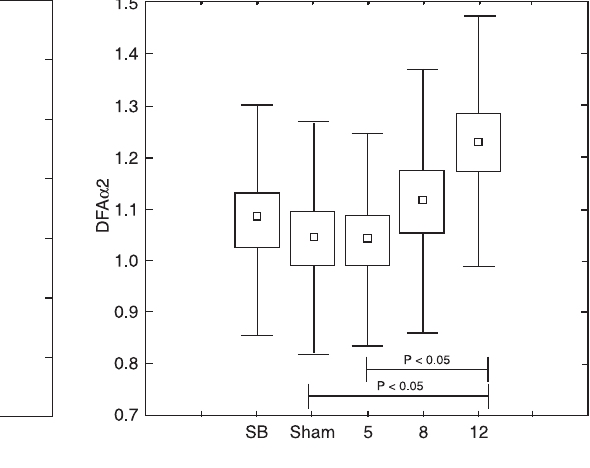
Figure 1. Postoperative heart rate variability responses after coronary artery bypass grafting surgery during positive airway pressure application. SB = spontaneous breathing; Sham = application of 3 cmH 2 O; 5 = appli- cation of 5 cmH 2 O; 8 = application of 8 cmH 2 O; 12 = application of 12 cmH 2 O; DFAα1 = detrended fluctua - tions analysis index (short-term correlation properties of R-R intervals (R-Ri)); DFAα2 = long-term correlation properties of R-Ri; SD2 = the standard deviation of the Poincaré plot along the line of identity. Data for groups containing 18 patients each were compared by repeated measures ANOVA with the Tukey post hoc test.